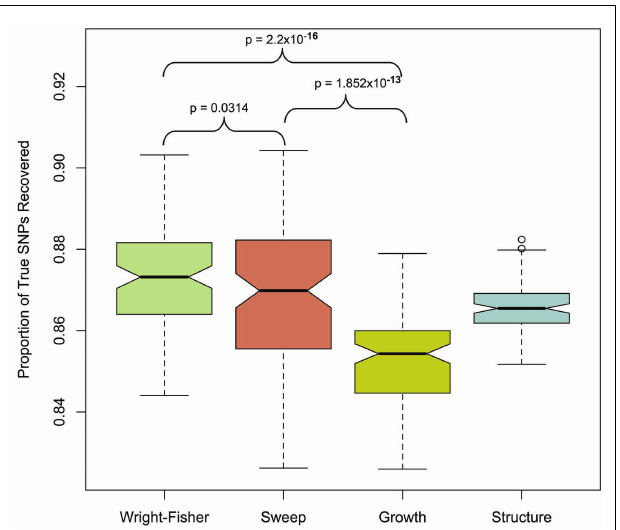
FIGURE 1 | Proportion of true SNPs recovered with 4 × sequencing. Data from 100 simulations is presented for each population model (only the selection model with τ = 0.005 and α = 1000 and structure model with F ST ≈ 0.37 is presented in each case, see Materials and Methods). Models were compared with paired t -test at a significance threshold of 5%. Note that the y -axis scale is limited from 0.84 to 0.92.The population structure model was not included in this particular statistical contrast (see Materials and